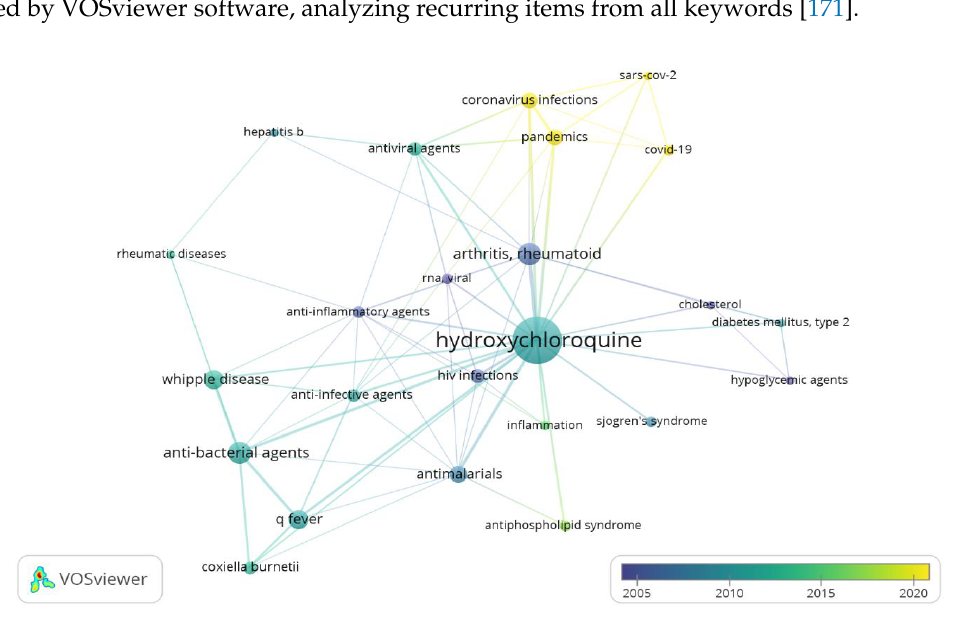
Figure 8. Bubble map visualizing items from articles included in the review. A total of 24 items representing the different fields of action of HCQ have been grouped into clusters, based on their relatedness. The distance between the two terms represents the relatedness of the terms. Generally, the smaller the distance between two terms, the stronger the relationship of the terms to each other. Two items are closer to each other if they co-occurred more frequently in the evaluated publications. The item size indicates the words’ appearance frequency (multiple appearances in a single manuscript count as one). As explained in the legend, the time colors indicate the research focus over the